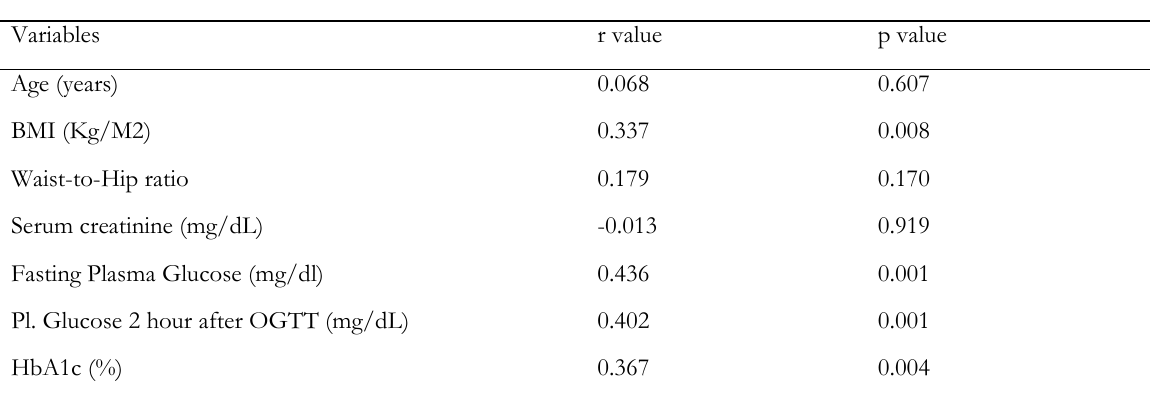
Table 3. Correlations of c-peptide with other variables in T2DM